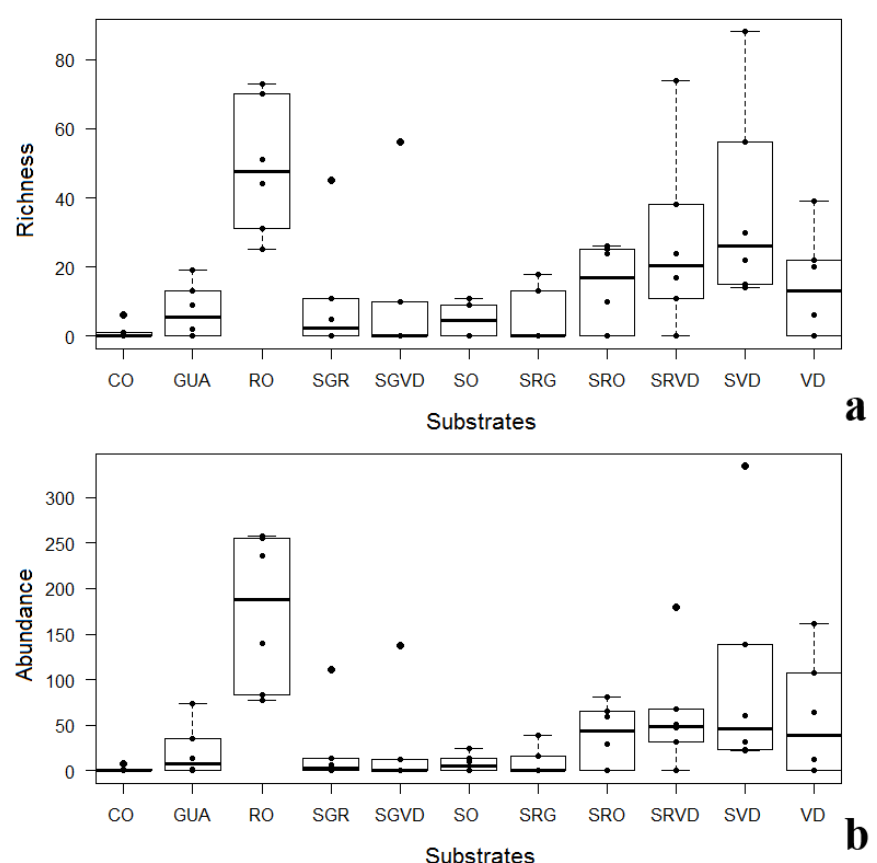
Figure 3 - Box-plots indicating medians, maximum and minimum values of (a) richness and (b) abundances invertebrates in different categories of substrates present in the Presidente Olegário caves, Minas Gerais, Brazil. The points are the (a) richness and (b) abundance for each sample. RO - rocky; CO - concretions; SO - soil; SRO - soil and rock; SGR - soil and gravel; SRVD - soil, rock and vegetal debris; SGVD - soil, gravel and vegetal debris; SVD - soil and vegetal debris; VD - vegetal debris; SRG – soil, rock and guano; GUA -